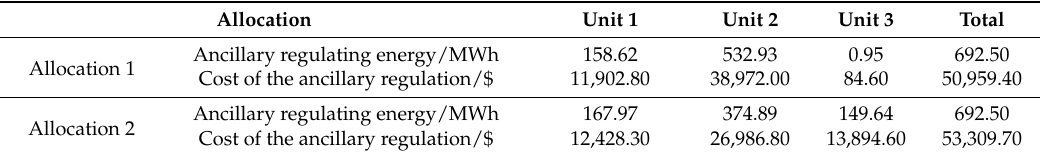
Table 4. Comparisons of different allocations.